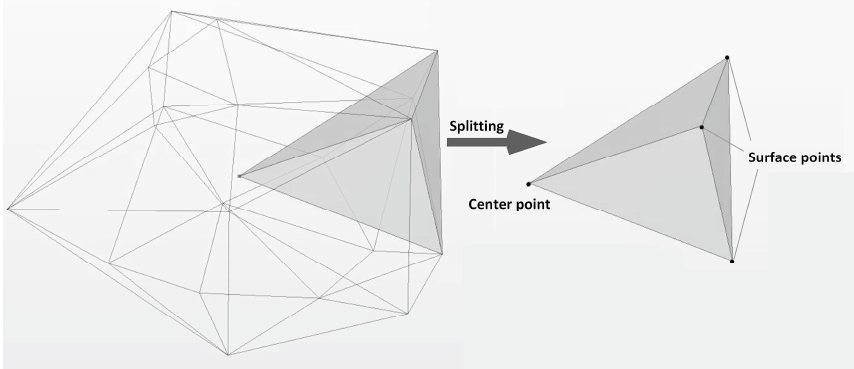
Figure 4. The fl owchart of the moving-and-densifying algorithm.